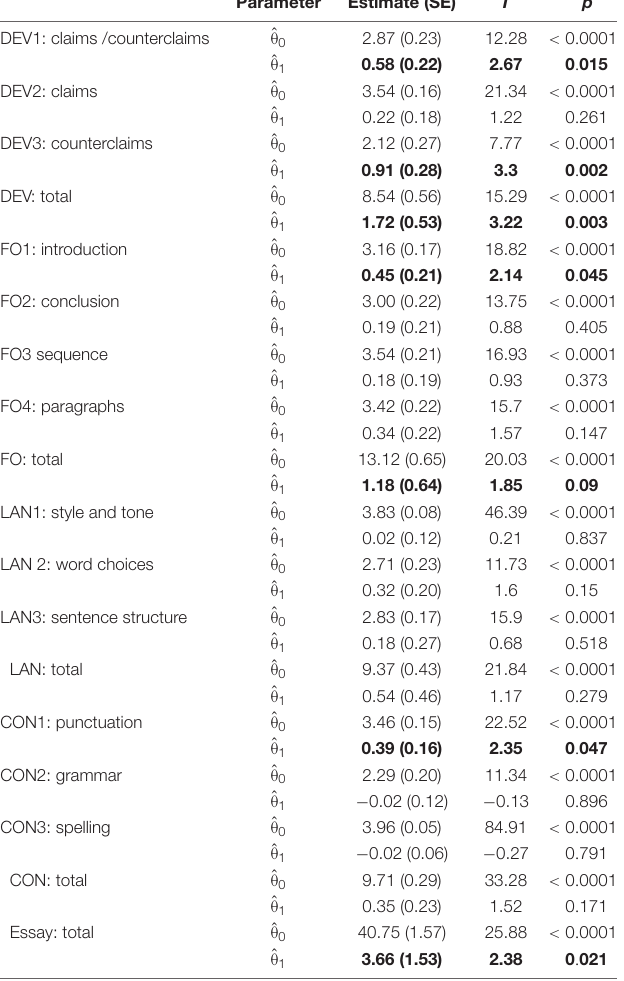
TABLE 2 | Results of the Two-level analyses of essay data by sub-criteria, criteria, and essay total. Parameter Estimate (SE) T p